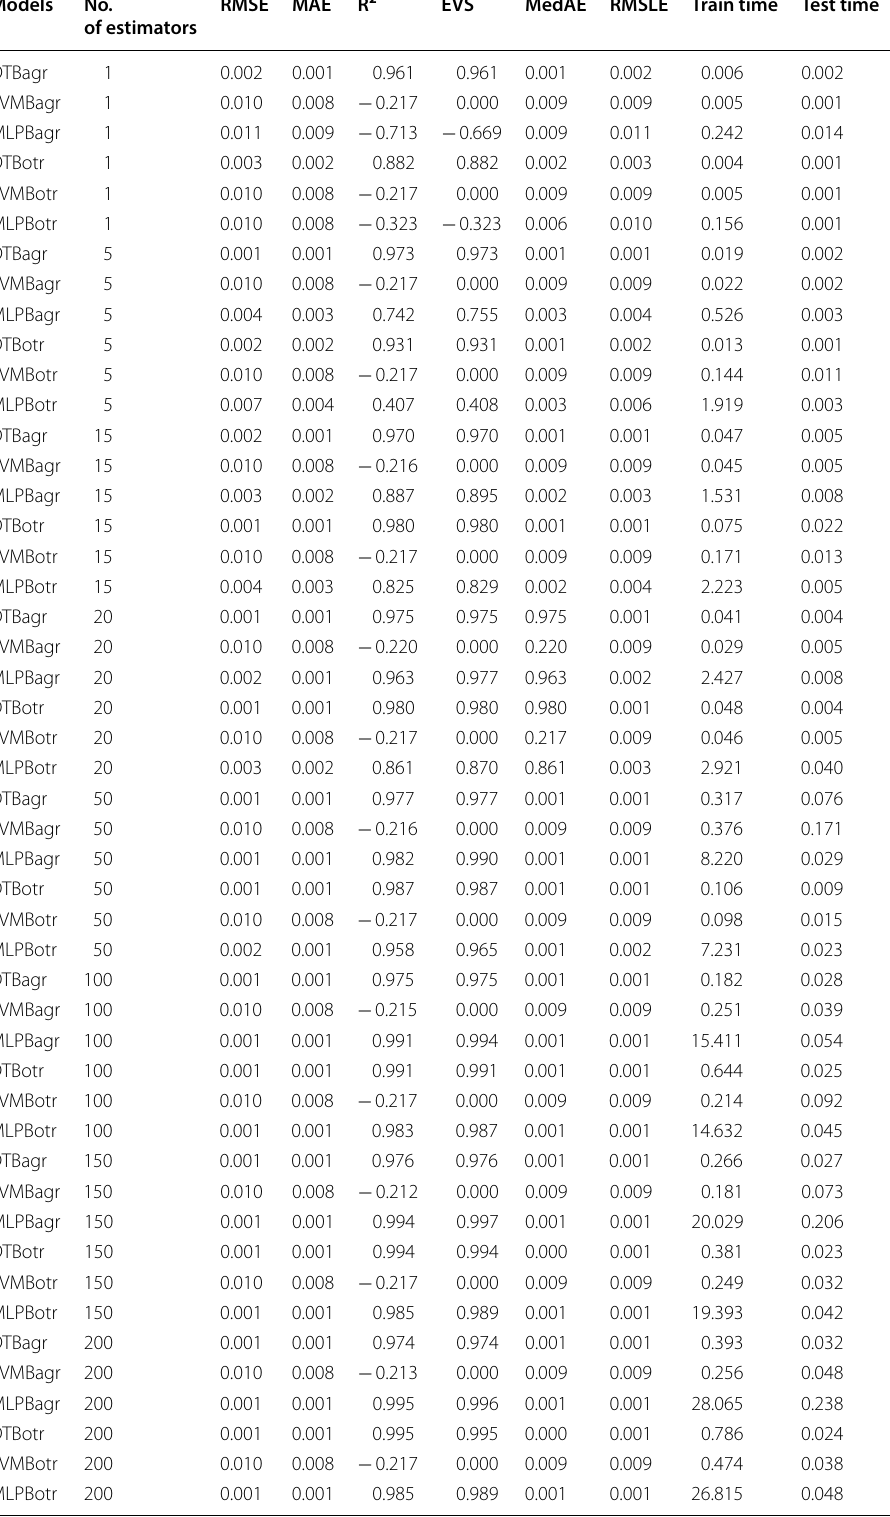
Table 17 Bagging and boosting ensemble regressors error metrics result over GSE dataset